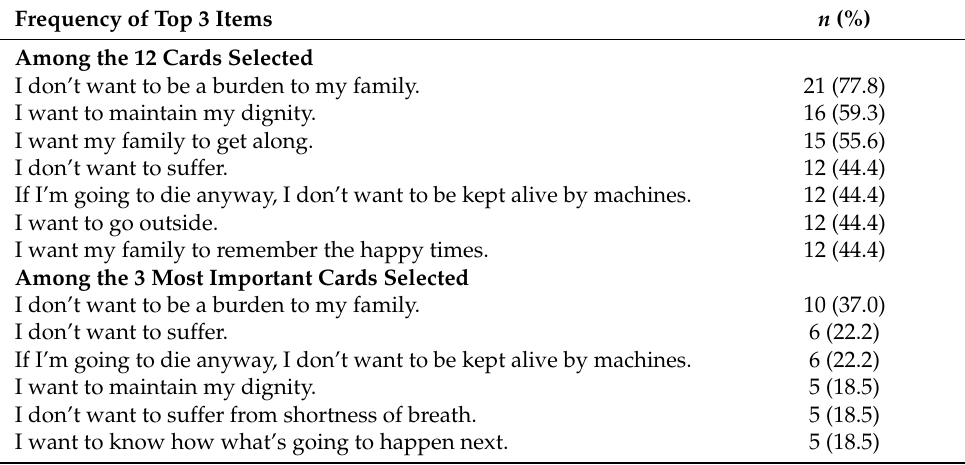
Table 3. Card selection result in the HHCG group ( N =